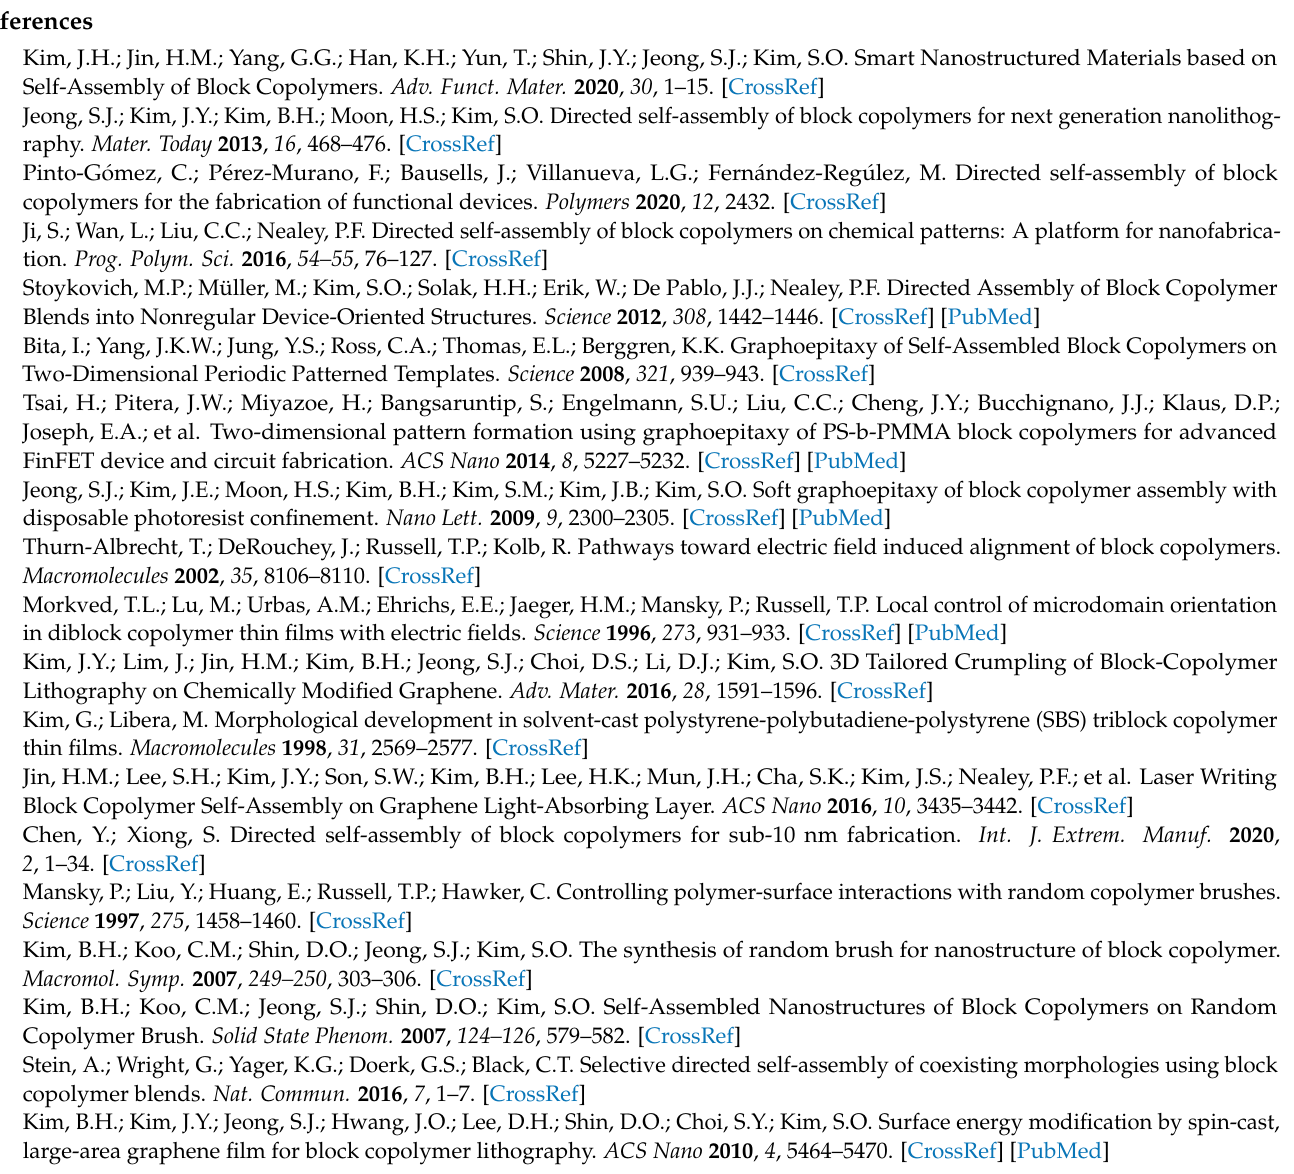
( c ) W = 270 nm, and ( d ) W = 225 nm, Table S1. Single/multiple orientations of lamella-forming BCP thin films inside various silicon